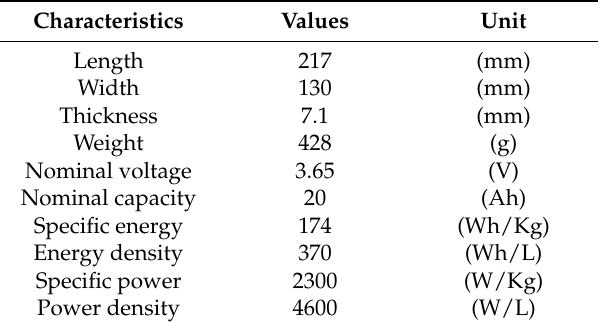
Table 1. Characteristics of the nickel manganese cobalt (NMC)